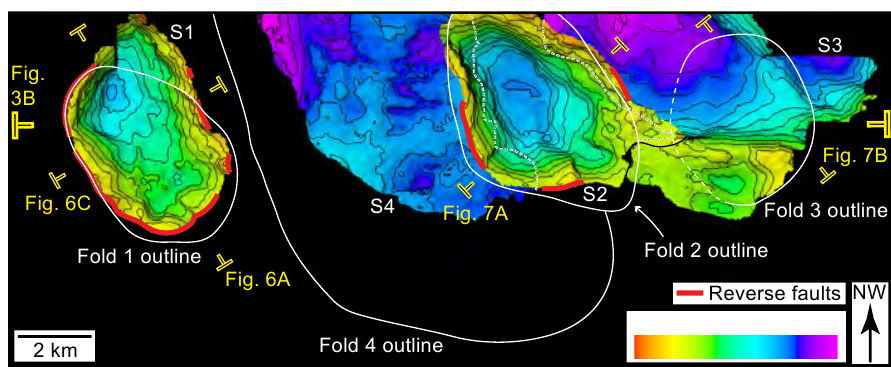
Figure 5: Depth-structure map of S1–S4 highlighting the location of reverse faults around sill edges and the position folds 1-4.